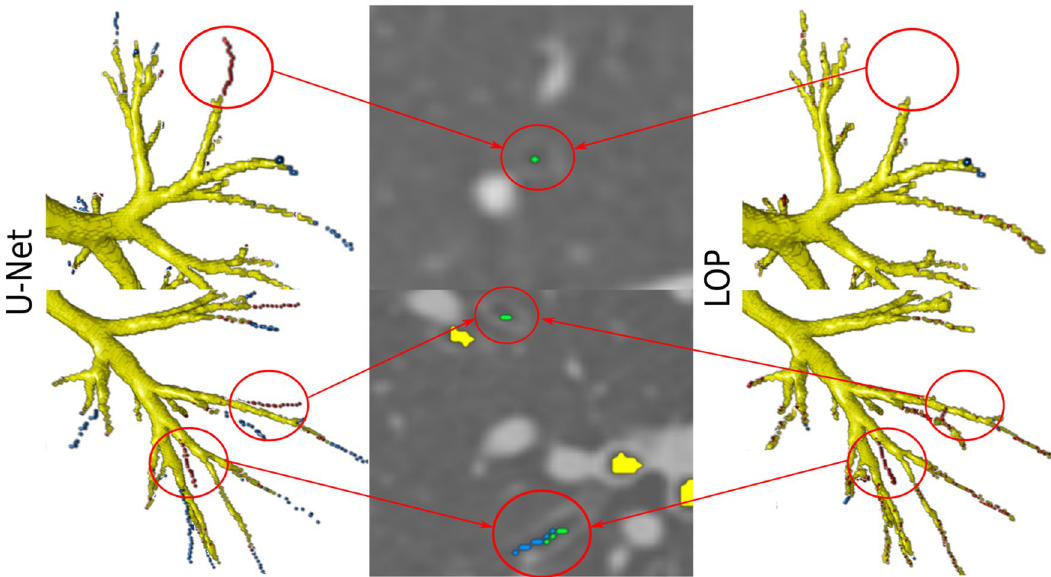
Figure 6. Visualization of examples of predicted false positive branches on the DLCST data, obtained by our U-Net-based method and missed by the kNN-VS and LOP methods, that are actually real airways missing in the reference segmentations. The last earmarked branch is detected by the LOP method but with errors: with leakage outside the airway wall. In the 3D visualizations the true positives are displayed in yellow, centerline false negatives in blue and centerline false positives in red. We also show the overlay of the predicted airway centerline masks with the CT scan, showing that the earmarked branches are real airways. The predicted centerlines by our U-Net method are displayed in green, those by the LOP method in blue, and the reference segmentations in yellow.